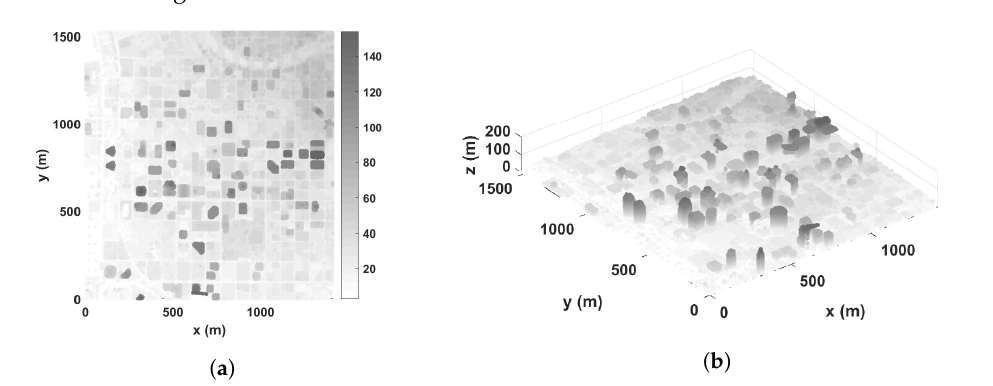
Figure 8. Visualization of the selected urban data in ( a ) top view and ( b ) 3D